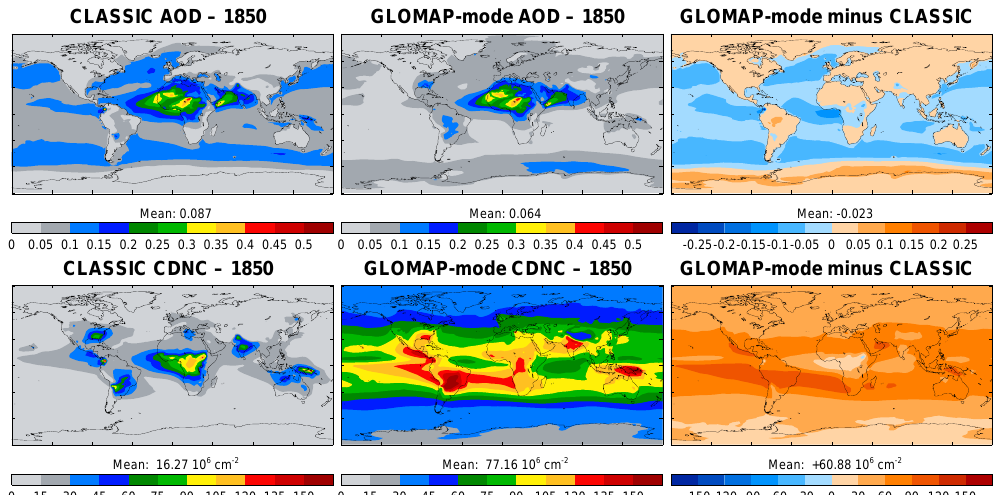
Fig. 6. Top row: aerosol optical depth (AOD) at 0.55µm in CLASSIC (left), GLOMAP-mode (middle) and their difference (right). Bottom row: same as top row, but for the column-integrated cloud droplet number concentration (CDNC), in 10 6 cm − 2 . CDNC is integrated over the lowermost 10km of the atmosphere. All simulations use aerosol and precursor emissions for the year